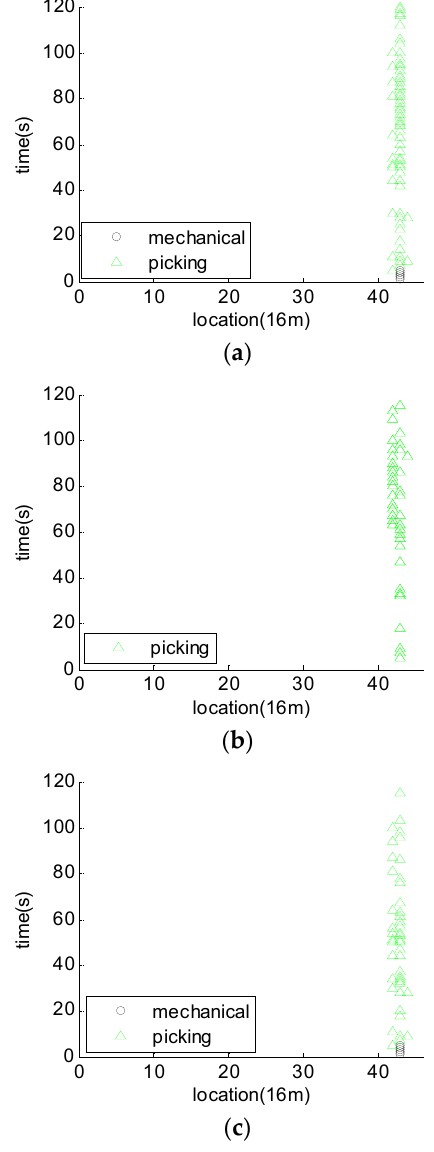
Figure 21. The identification results of picking signals. ( a ) The first group of picking signals; ( b ) The second group of picking signals; ( c ) The third group of picking signals.